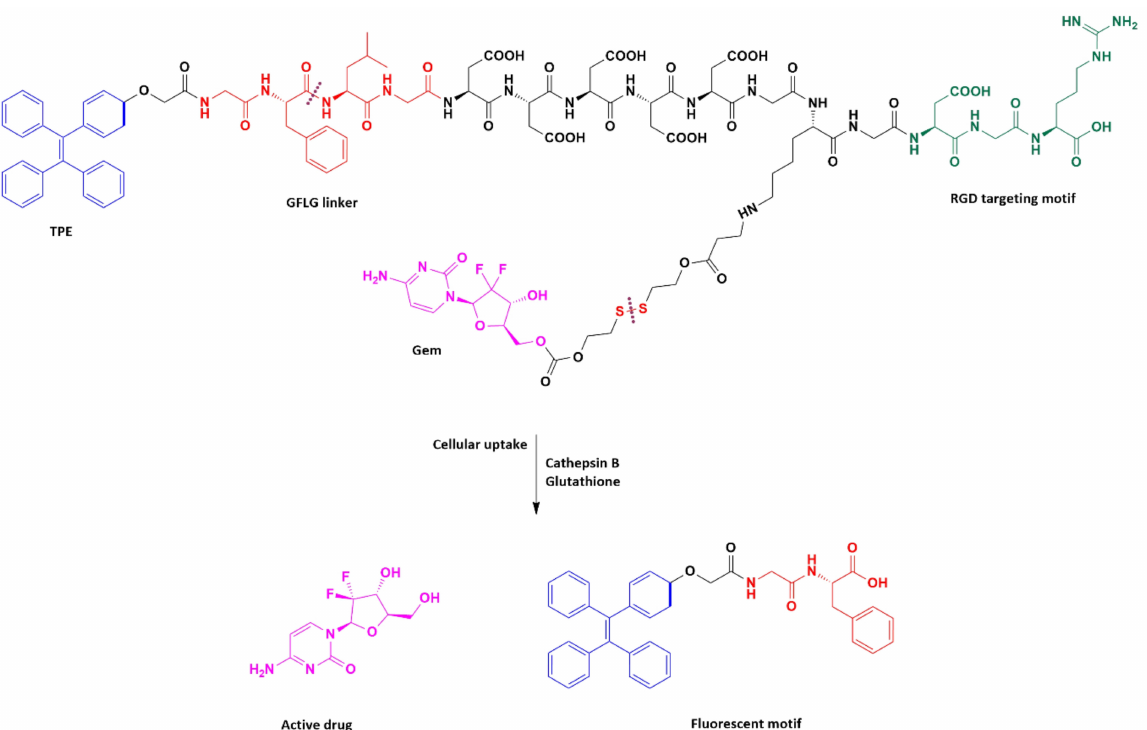
Figure 5. The structure of TPE-Gem-RGD for cathepsin B-responsive fluorescent product and reduction-responsive drug release. After cleavage of GFLG peptide by cathepsin B, intracellular fluorescence light up could be achieved. The conjugated anticancer drug- gemcitabine- is expected to be released upon the trigger of high intracellular glutathione